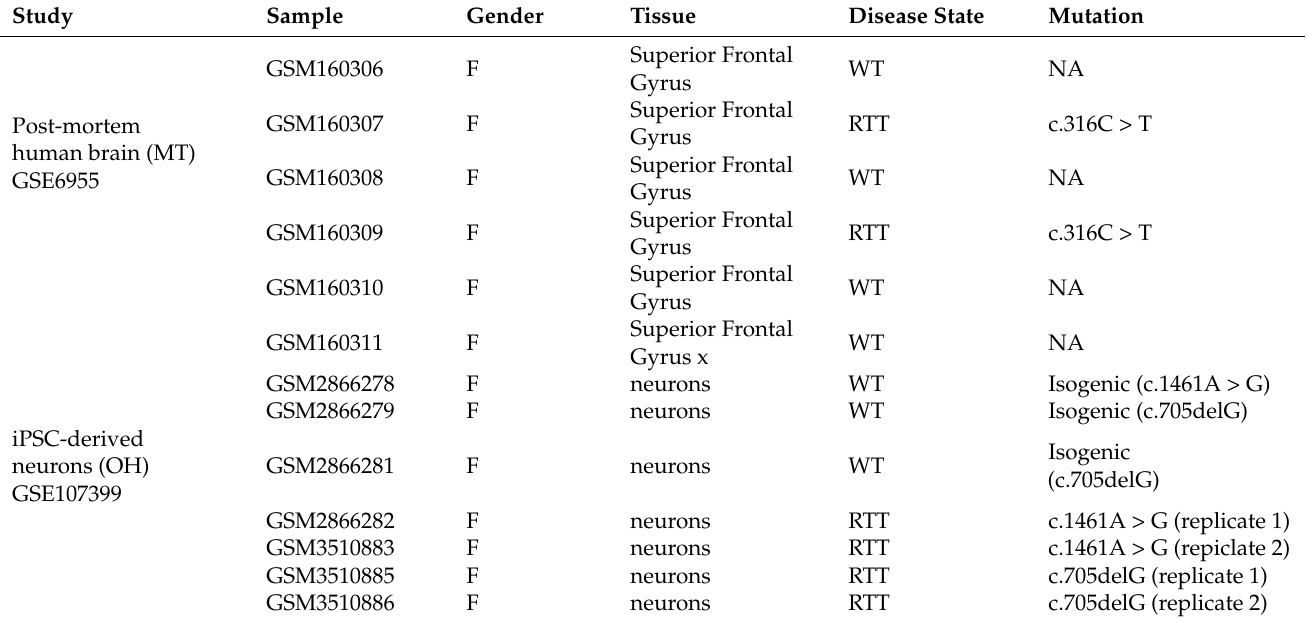
Table 3. Summary of samples used in the DGE analysis. WT refers to wild type, RTT refers to Rett Syndrome, and NA refers to not applicable; F refers to feminine and M to masculine. Gender Tissue Disease State